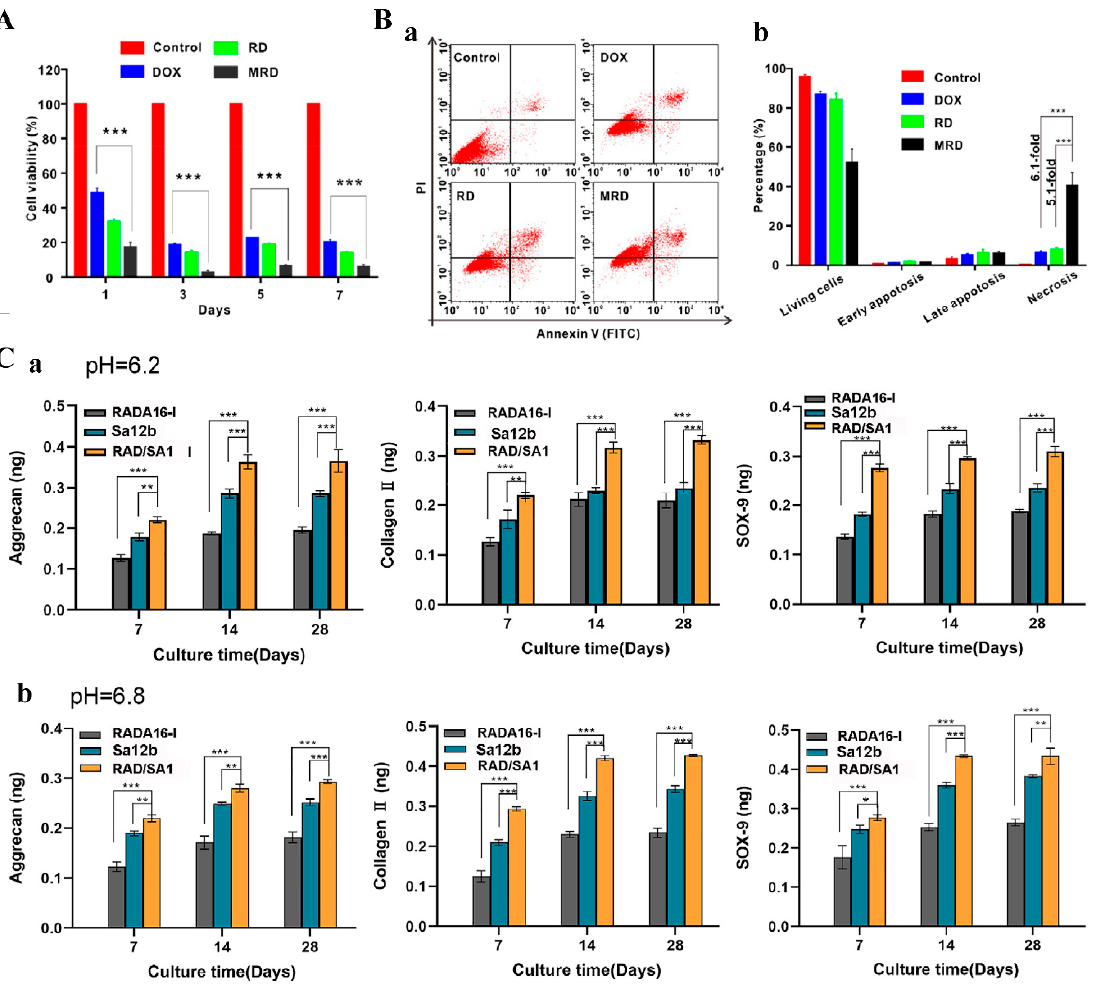
Figure 5. Resisting negative factors. ( A ) Measurement of cell viability in MRD hydrogel treatment using the CCK-8 assay. ( B ) Flow cytometry measurement of cell apoptosis induced by DOX, RD, or MRD hydrogel. Data are presented as the mean ± SEM ( n = 3). Adapted with permission from Ref. [42]. Copyright 2018 Acs Nano. *** indicates p < 0.001. ( C ) ELISA revealed that the amounts of collagen II, aggrecan, and SOX-9 secreted by hNPMSCs were significantly different among the three groups (RAD/SA1, Sa12b, and RADA16-I) after 7, 14, and 28 days, respectively. ( a ) hNPMSCs were cultured at pH 6.2. ( b ) hNPMSCs were cultured at pH 6.8. When the two groups are compared, * indicates p < 0.1, ** indicates p < 0.01, and *** indicates p < 0.001. Adapted with permission from Ref. [66]. Copyright 2022 Frontiers in Cell and Developmental Biology.